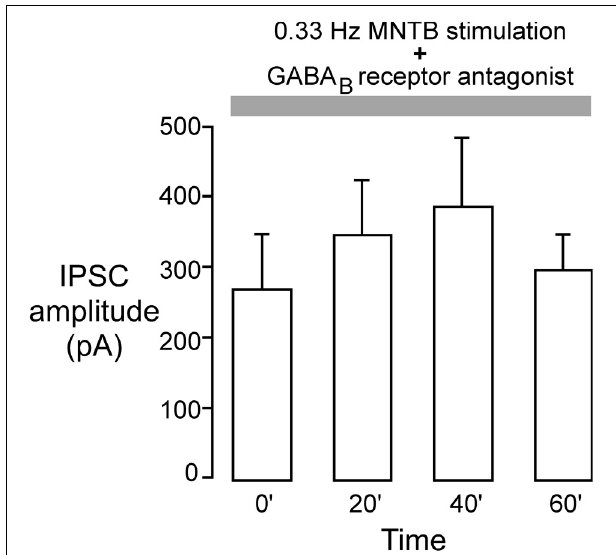
FIGURE 5 | GABA B receptor blockade perturbs inhibitory iLTP. MNTB was continuously stimulated at 0.033Hz for 1h while voltage clamp recordings were obtained from P12 to 15 LSO neurons in the presence of an ionotropic glutamate receptor antagonist ( V HOLD = 0mV). The GABA B receptor blocker, SCH-50911 (10 µ M), was present throughout the recordings. Under these conditions, IPSC amplitudes did not show any significant change toward potentiation. Each bar represents the mean current ( ± s.e.m.) calculated at the beginning of the experiment, and at 20, 40, and